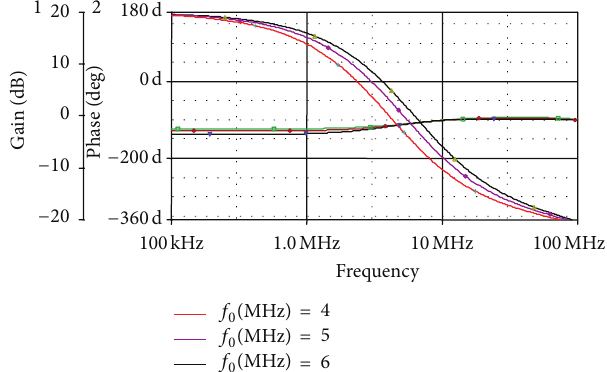
Figure 8: Frequency response showing gain and phase of 3rd order APS of Figure 4.